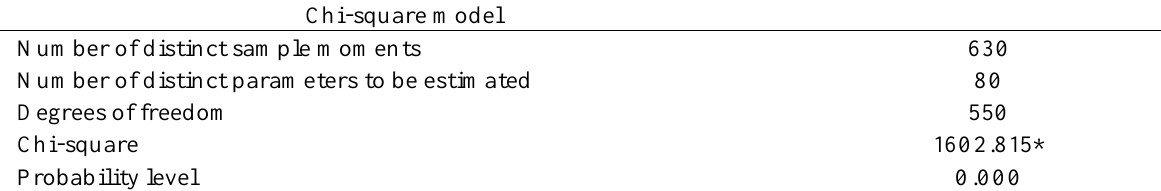
Note. *Minimum was achieved.